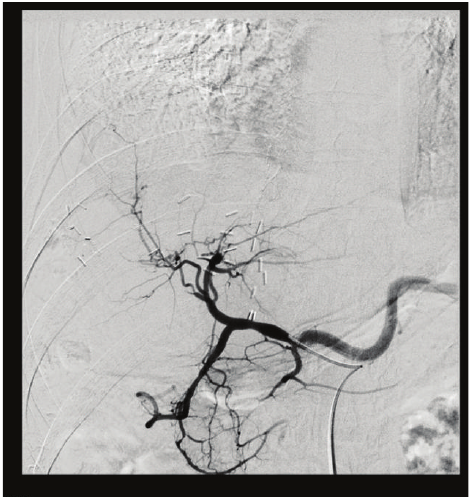
Figure8:Disappearanceofhepaticlesionsaftertransarterialembol-